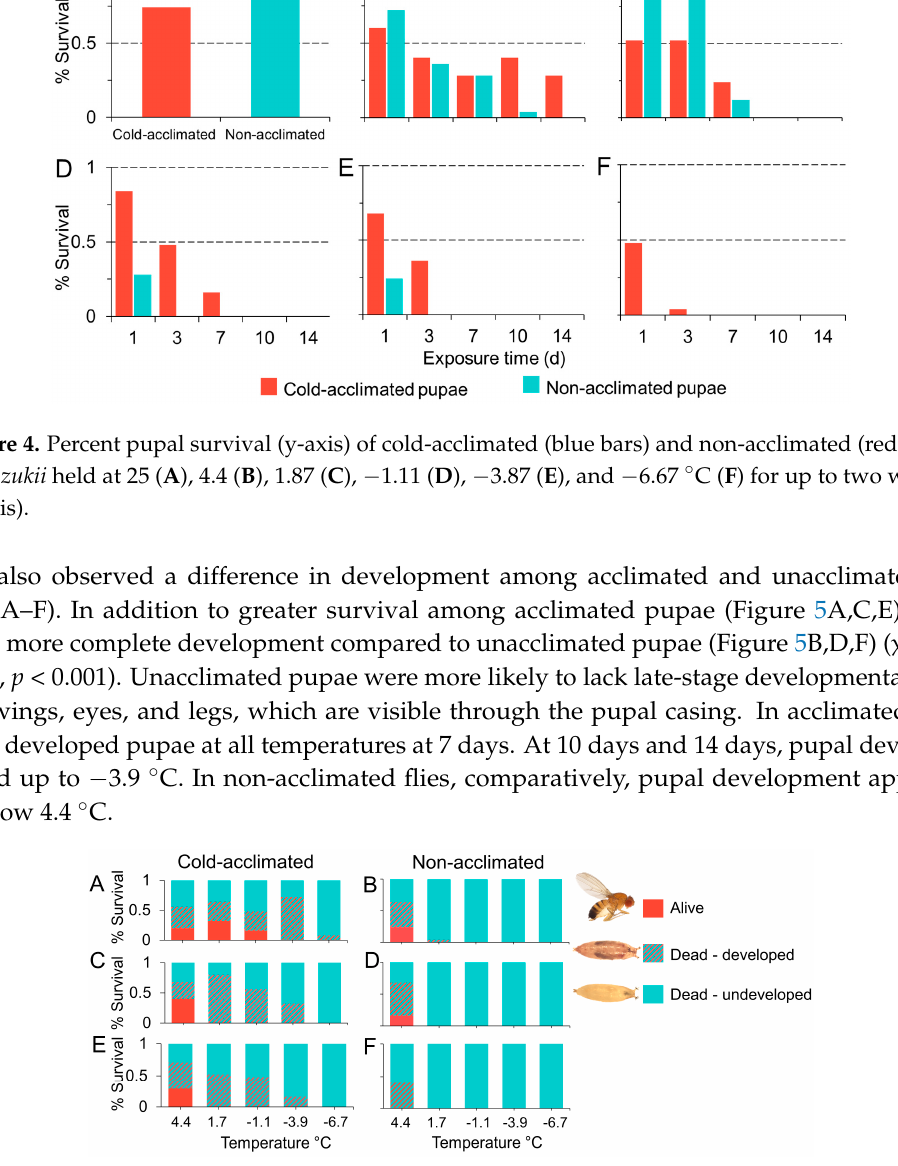
Figure 5. Percent survival and development of cold-acclimated ( A , C , E ) and non-acclimated ( B , D , F ) pupae exposed to low temperatures for 7 days ( A - B ), 10 days ( C - D ), or 14 days ( E - F ). Red bars indicate insects that eclosed during the observation period.